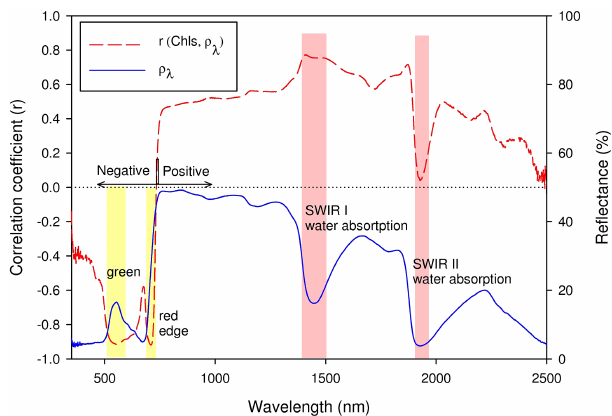
Figure 3. Generalized reflectance spectra of Cinnamomum cam- phora leaf (solid line) and trends of the corresponding correlation coefficients (dashed line) between the concentration of total chloro- phyll and reflectance in the visible–infrared wavelength region. Re- sults derived from the training data set, the 50 leaf